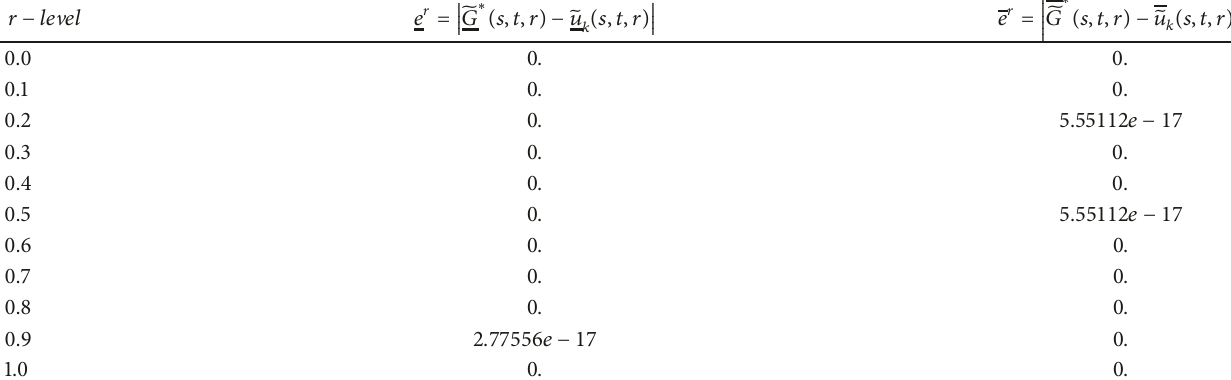
Table 4: The absolute errors on the level sets with 𝑛 = 2 , 𝑘 = 8 for Example 14 by using the proposed method in (𝑠, 𝑡) = (0.5,0.5) . 𝑟 − 𝑙𝑒 V